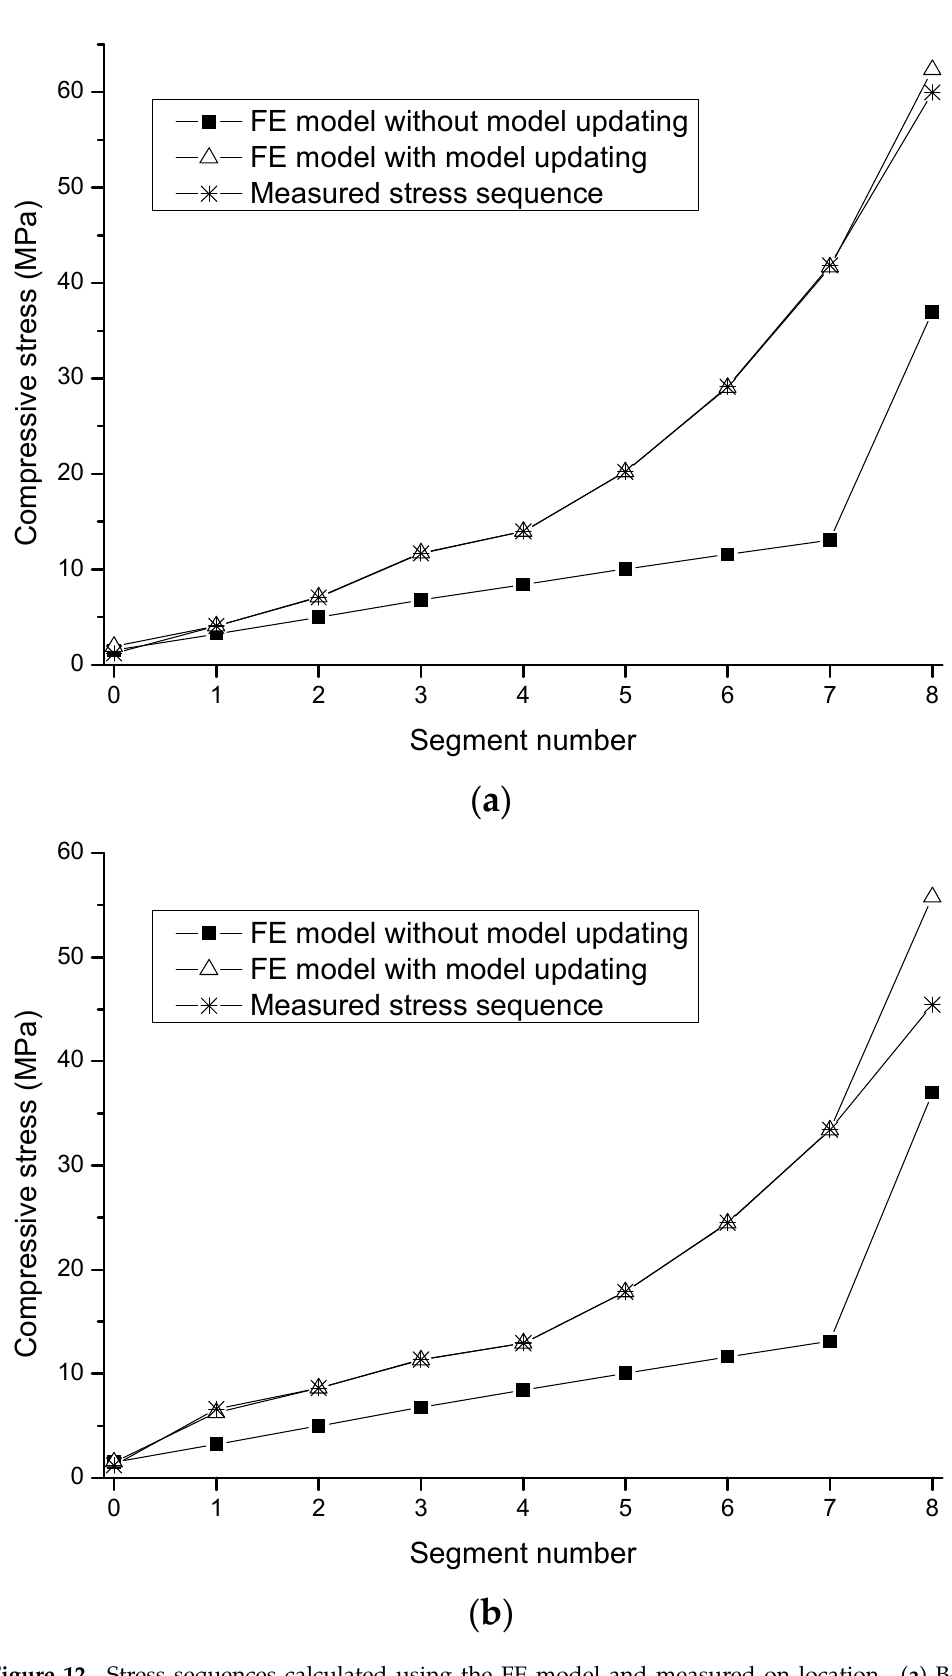
Figure 12. Stress sequences calculated using the FE model and measured on location. ( a ) B-B cross-section; ( b ) C-C cross ‐ section.